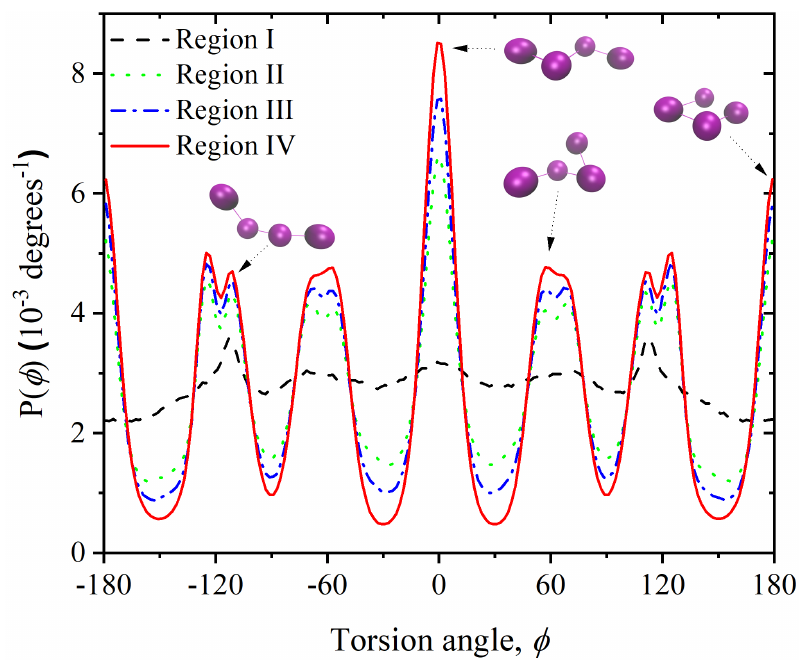
Figure 8. Probability distribution of torsion angles averaged over Regions I through IV. Value of 0 ◦ corresponds to the trans conformation. Also shown are four-site arrangements that correspond to specific torsion angles, as indicated by the